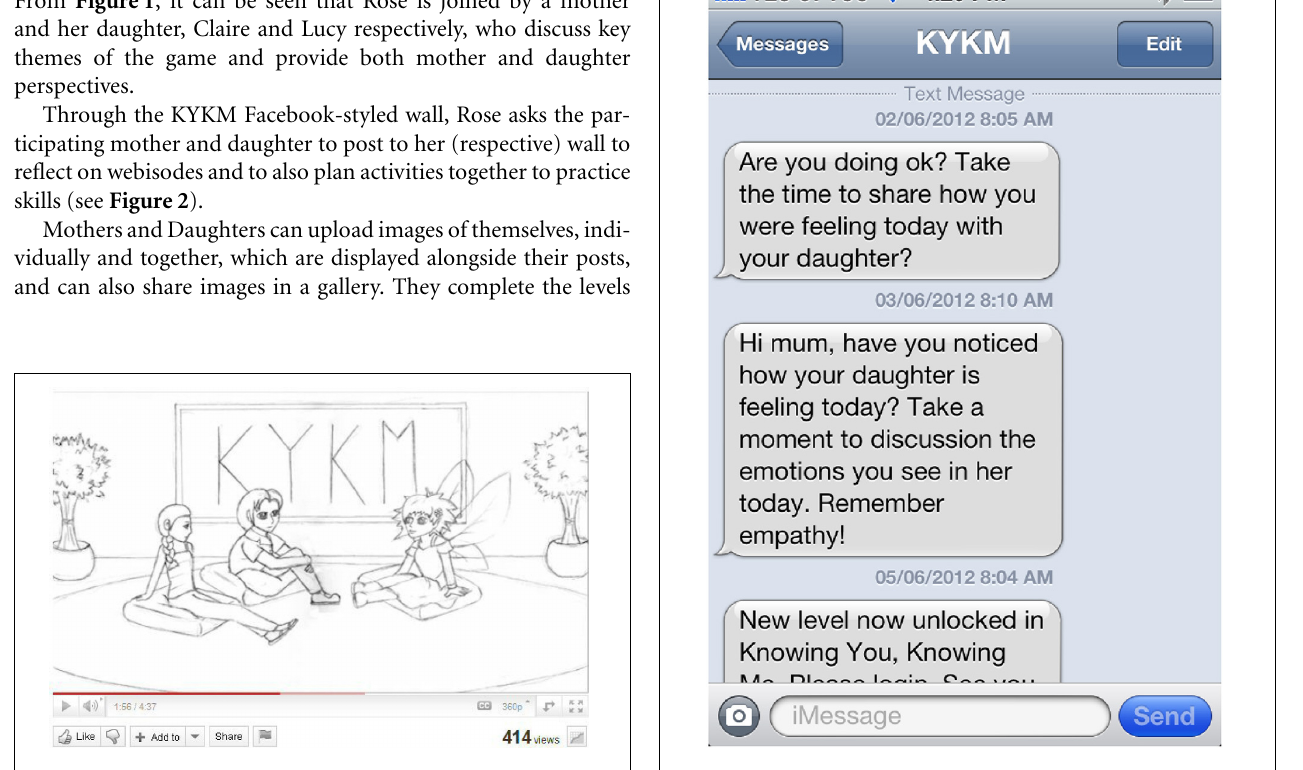
FIGURE 3 | Screenshot of mother’s mobile phone showing two SMS messages and new level unlocked message.